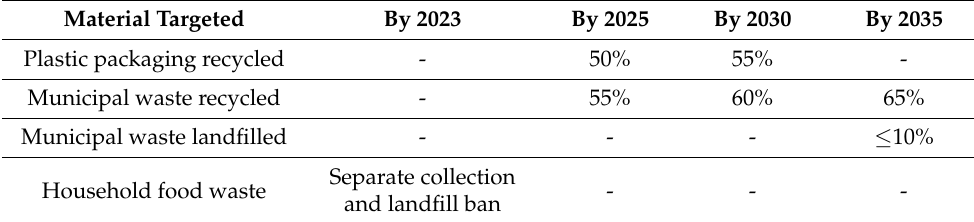
Table 2. Targets and timelines under the EU’s Circular Economy Package